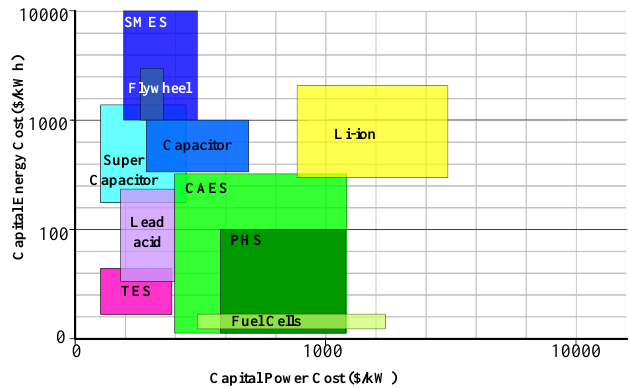
Figure 1. Capital energy cost vs. capital power cost [6–10].